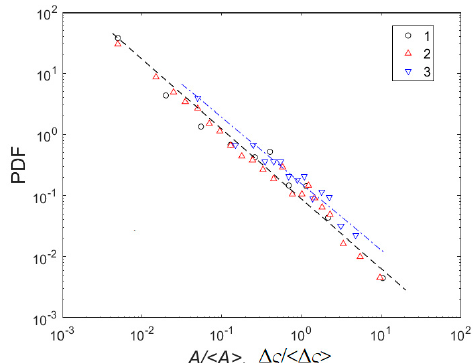
Figure 4. Comparison of PDF for local and global responses: 1—Strain-rate response over a 16-mm base, β = 1.05 ± 0.06. 2—One local extensometer, β = 1.11 ± 0.04. 3—Stress serrations, β = 1.03 ± 0.07. Dashed line is traced for the local extensometer; dash-and-dot line for stress serrations.